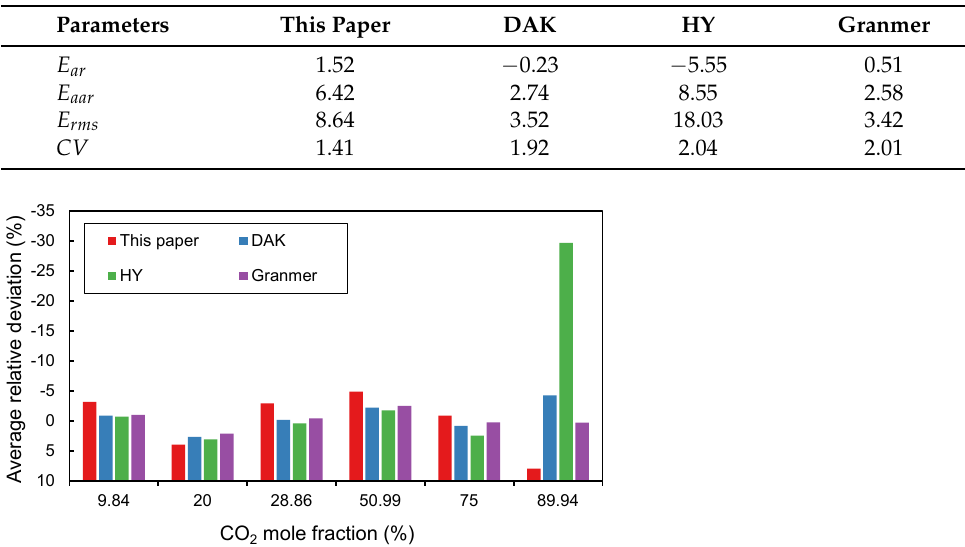
Figure 4. Validation of the empirical correlations by the six natural gas mixtures from the literature with different CO 2